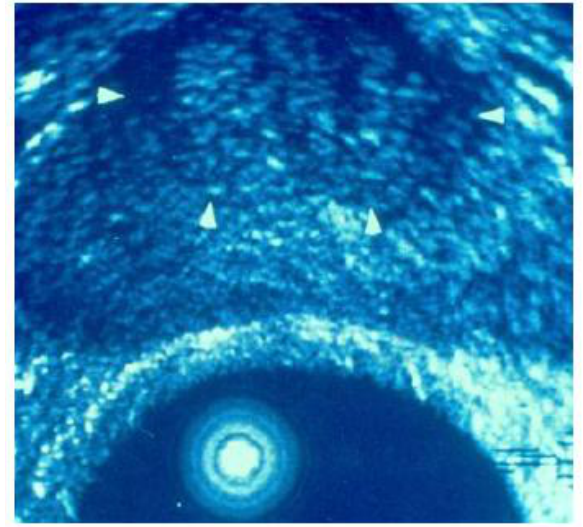
Figure 1. Ultrasound probe in rectum illustrating the relative relationship of rectum and prostate: white arrows indicate the transition zone